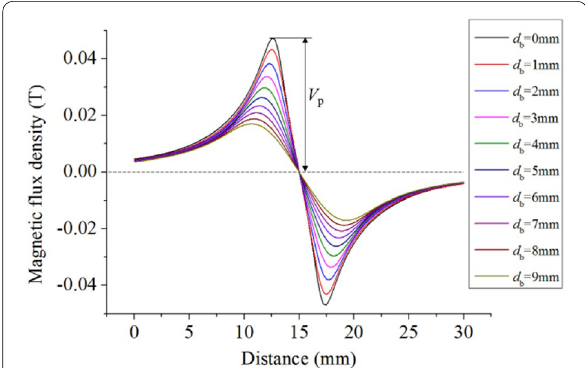
B m-defect - free = B bk.